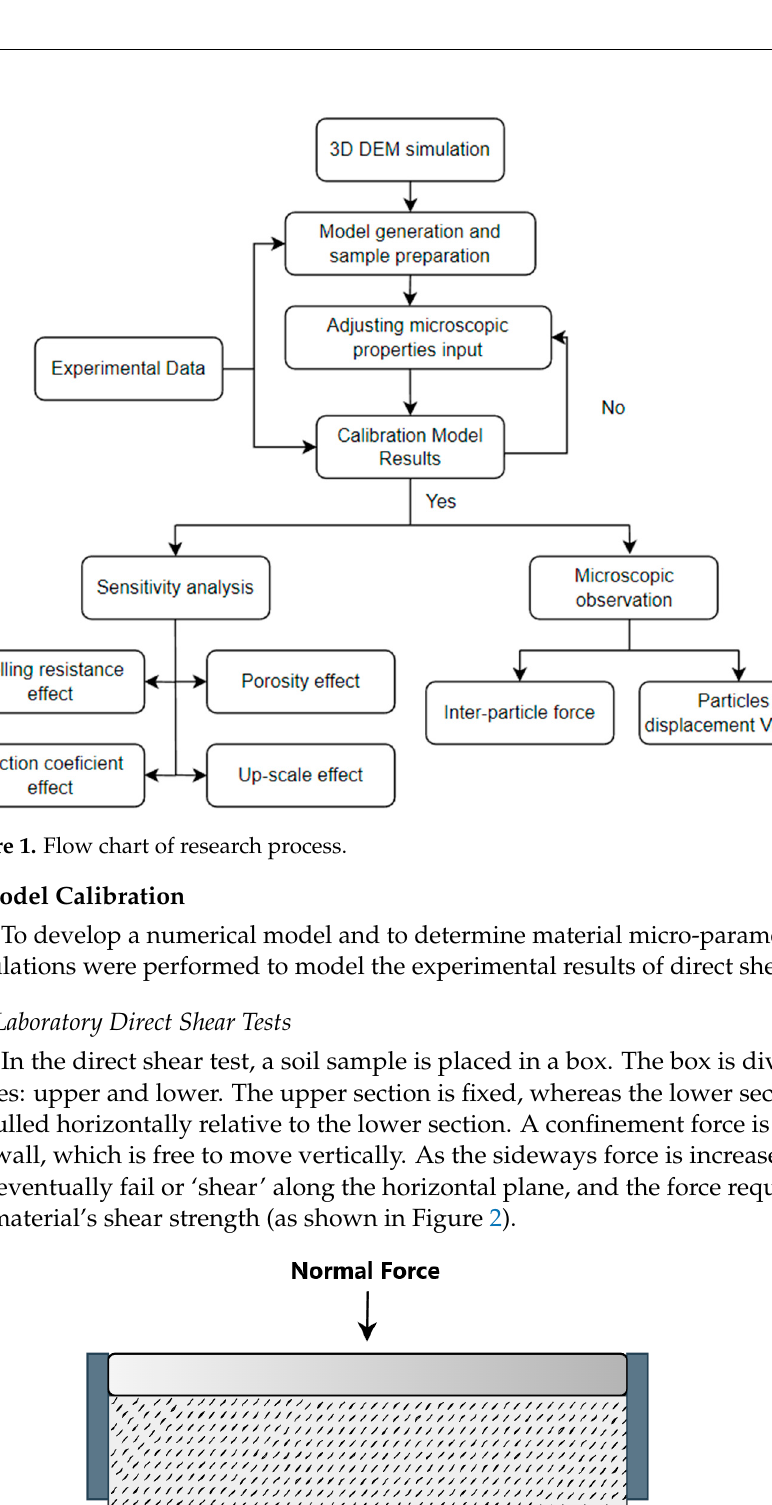
Figure 2. Schematic view of direct shear test.